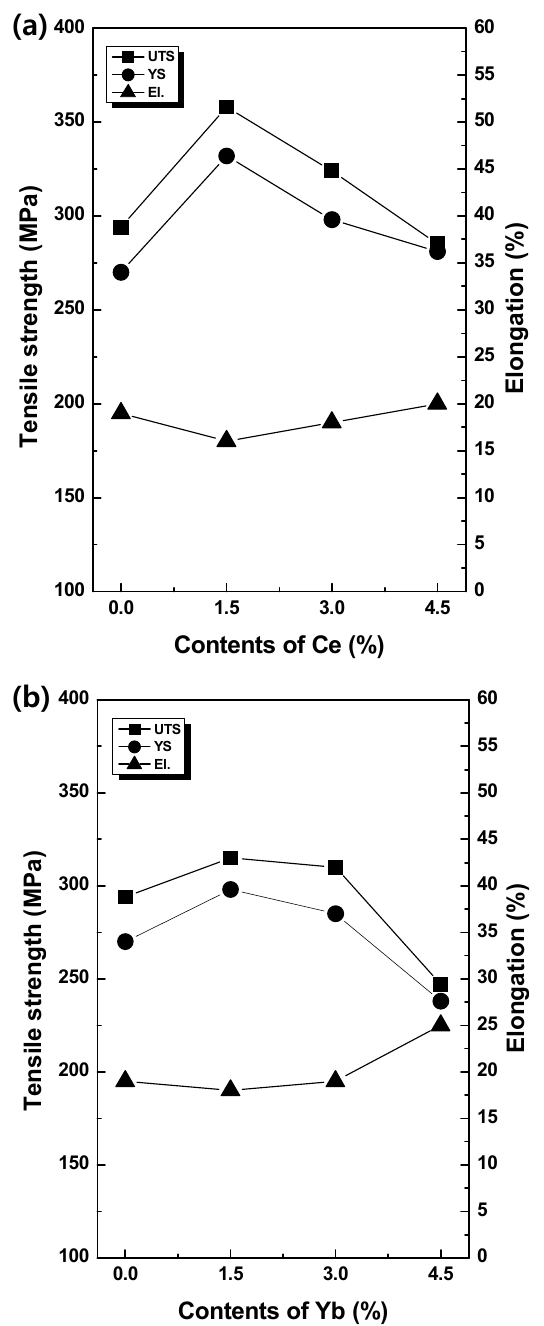
Figure 7. Mechanical properties of the extruded alloys at 200 °C: ( a ) Mg-Zn-Y-Ce alloys; ( b ) Mg-Zn-Y-Yb alloys.